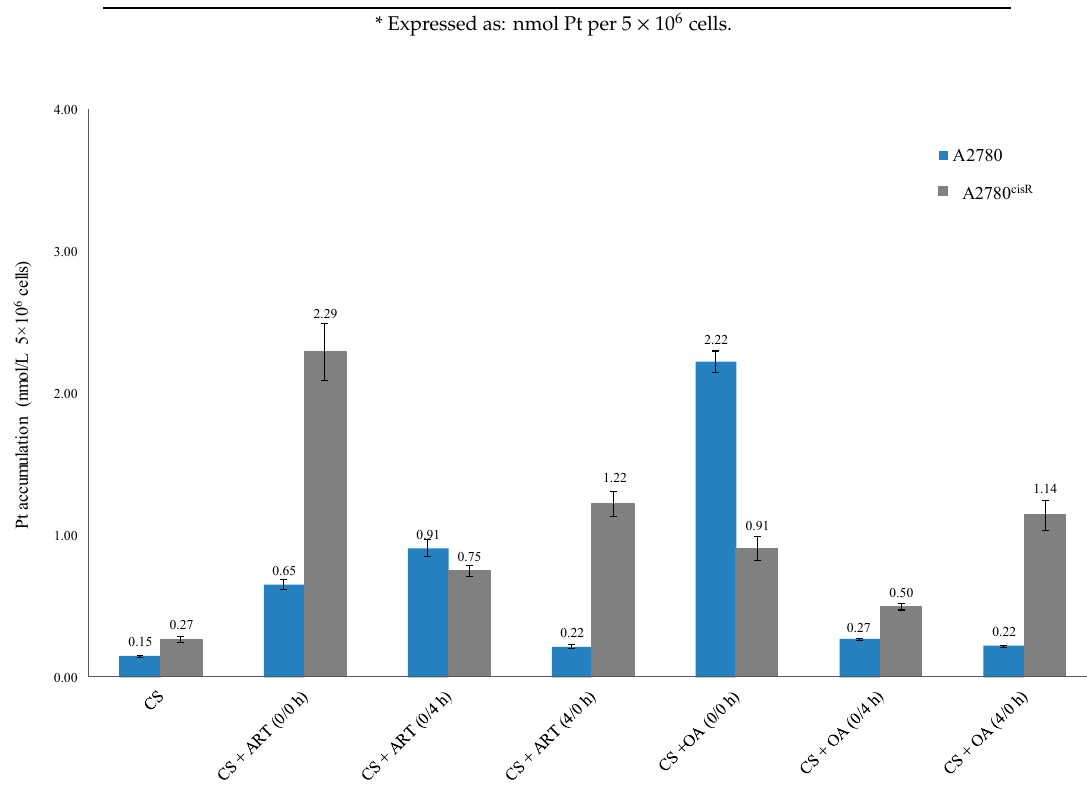
Figure 3. Platinum accumulation level from CS alone and in combination with ART and OA.